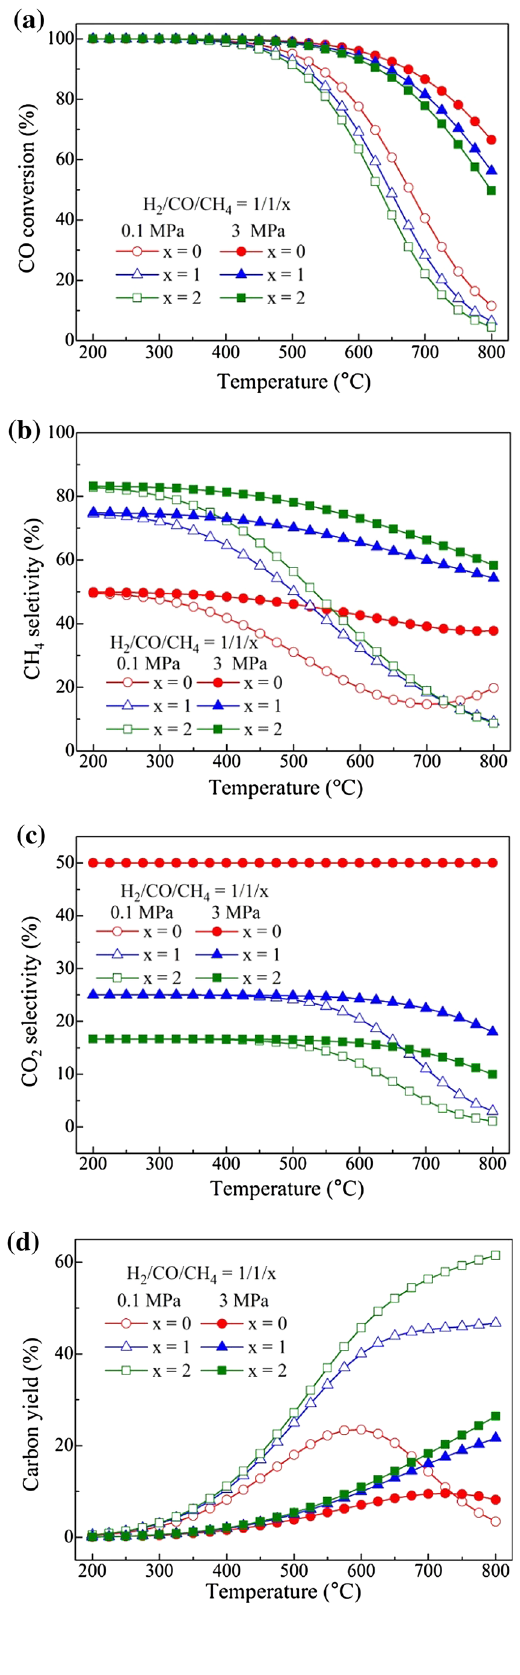
c Fig. 6 Effect of CH